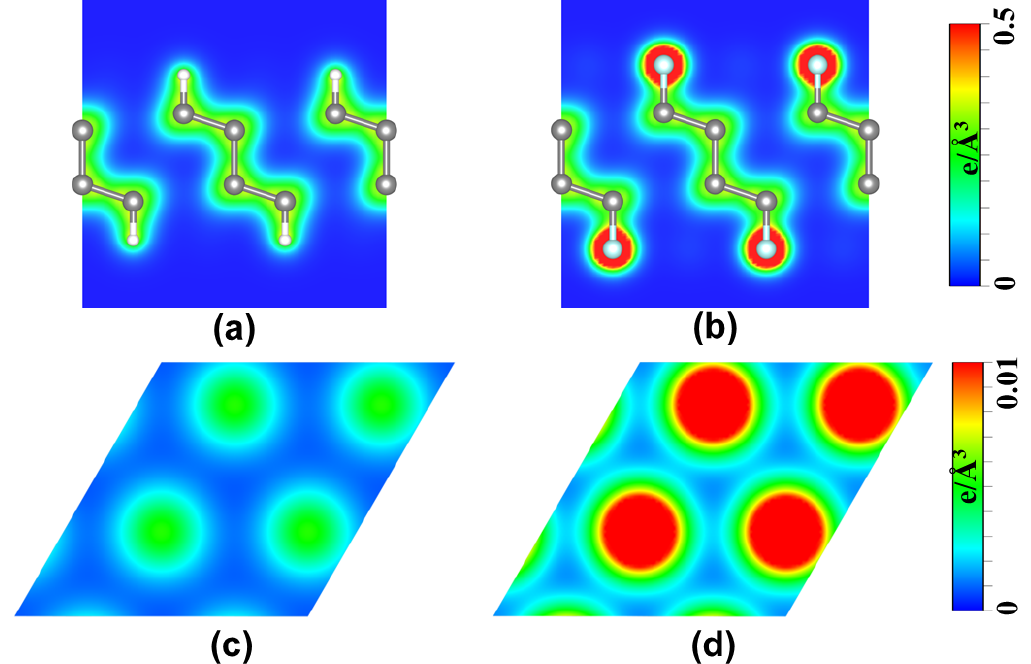
Figure 8. Maps of the charge density. Profile charge density plots along the maximum path of ( a ) H-diamane and ( b ) F-diamane. Charge distribution at a distance of 1 Å from the top passivated atoms layer for ( c ) H-diamane and ( d ) F-diamane.